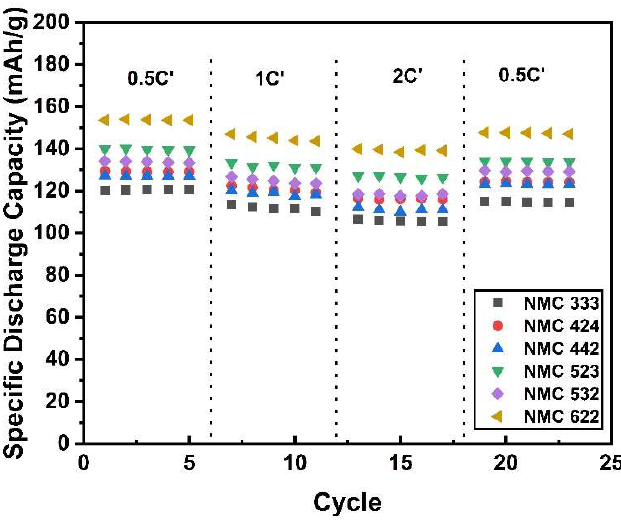
Figure 9. Rate-ability analysis of as-prepared samples.